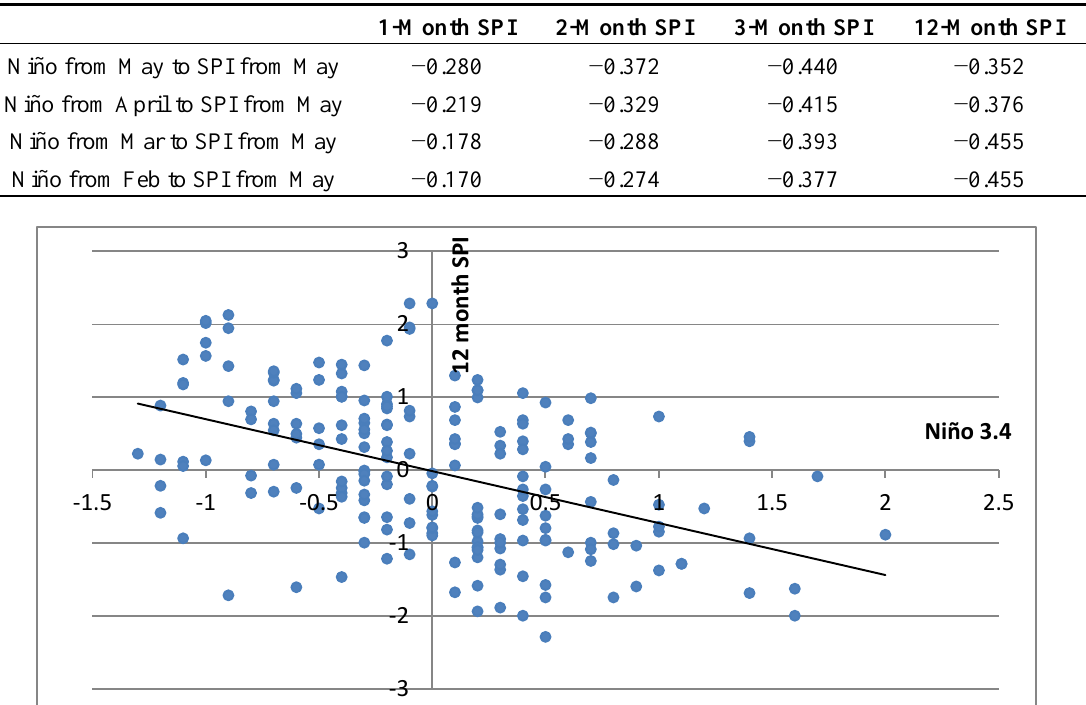
Figure 6. SPI values for growing season months ( i . e . May-November) and Niño 3.4 data: